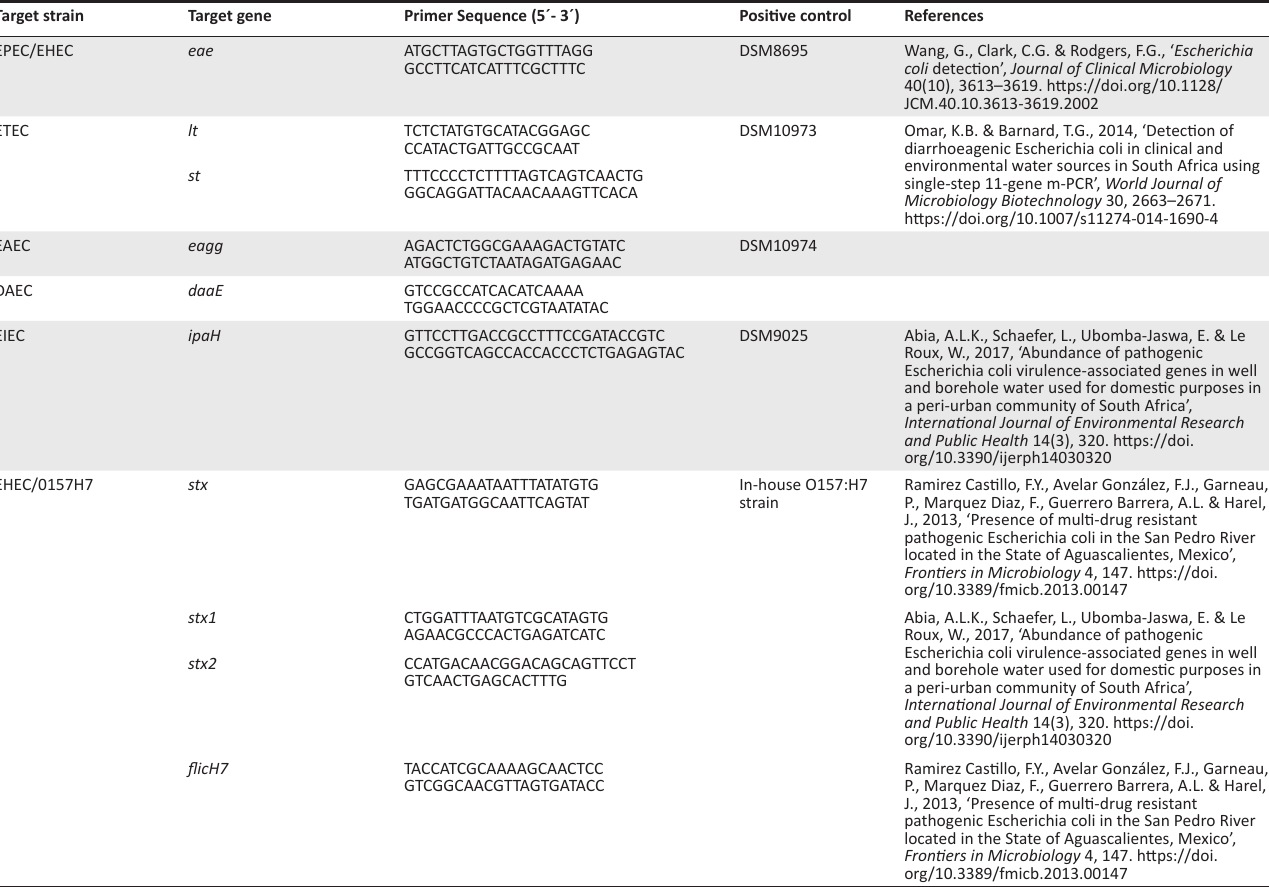
TABLE 1-A1: Primers and controls used for pathotypes identification.